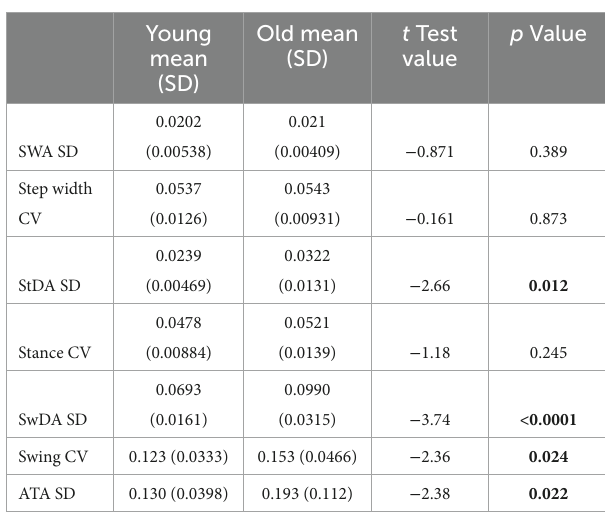
TABLE 2 Comparison of standard deviation (SD) of asymmetry measures and coefficient of variation (CV) of gait measures in young versus old subjects on self-paced and non-perturbed stepping-in-place tests performed with eyes